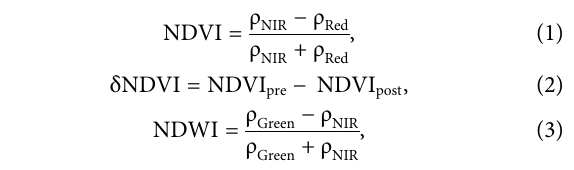
Frontiers in Earth Science |